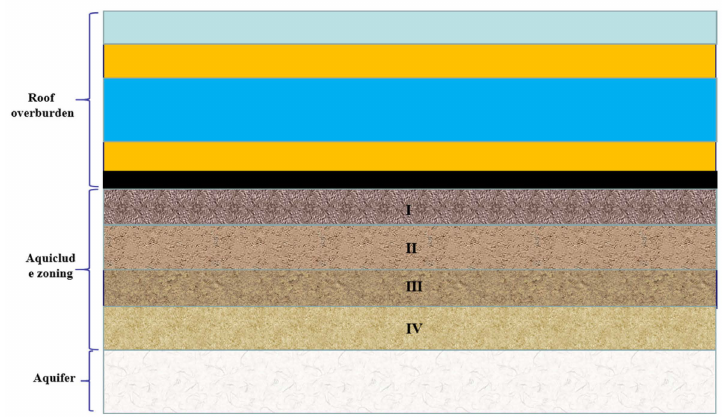
Figure 1. Different partitions of the water